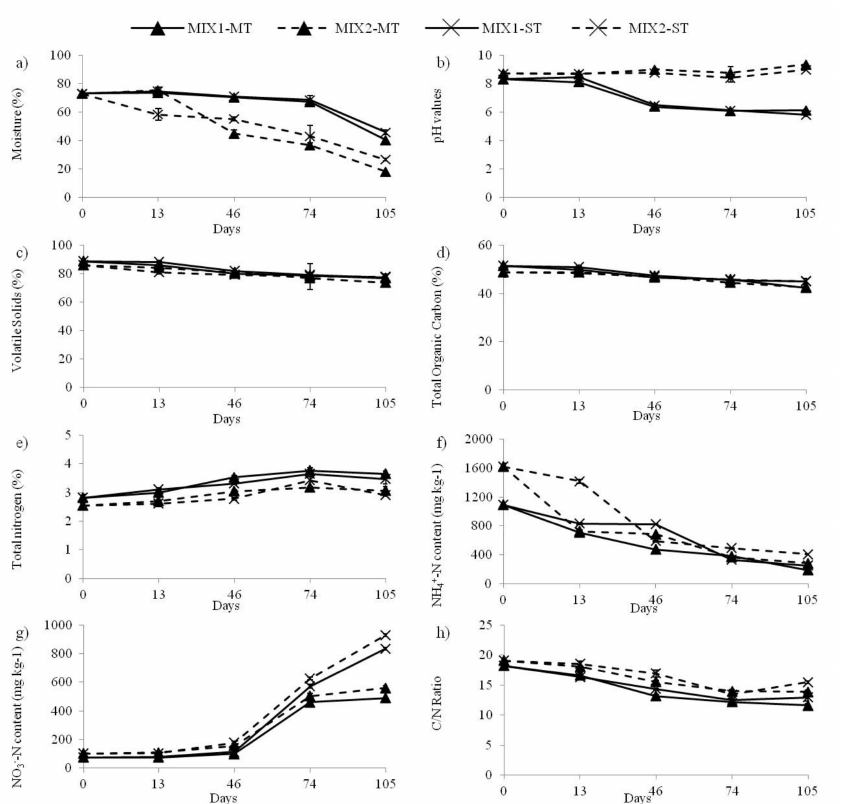
Figure 2. Changes in chemical properties of the investigated mixtures during the composting process. ( a ) Moisture content (%); ( b ) pH; ( c ) Volatile solids content (%); ( d ) Total organic carbon content (%); ( e ) Total nitrogen content (%); ( f ) Ammoniacal nitrogen content (%); ( g ) Nitric nitrogen content (%); ( h ) Carbon to nitrogen ratio. Mean value and standard deviation (vertical bar) of three replicates are